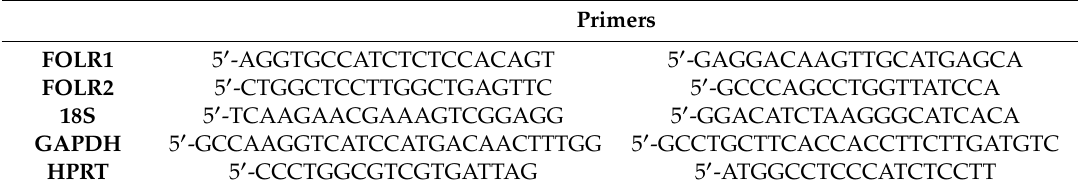
Table 2. List of the primers used for